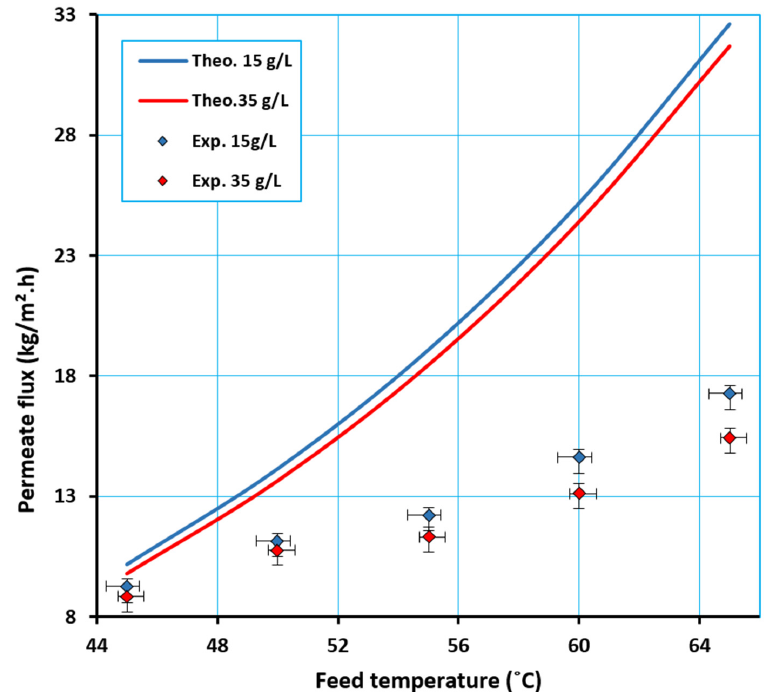
Figure 9. Influence of the feed temperature on the permeation flux at a feed concentration of 15 and 35 g/L NaCl at a feed flow rate of 1.07 L/min with τ = 1.9082.